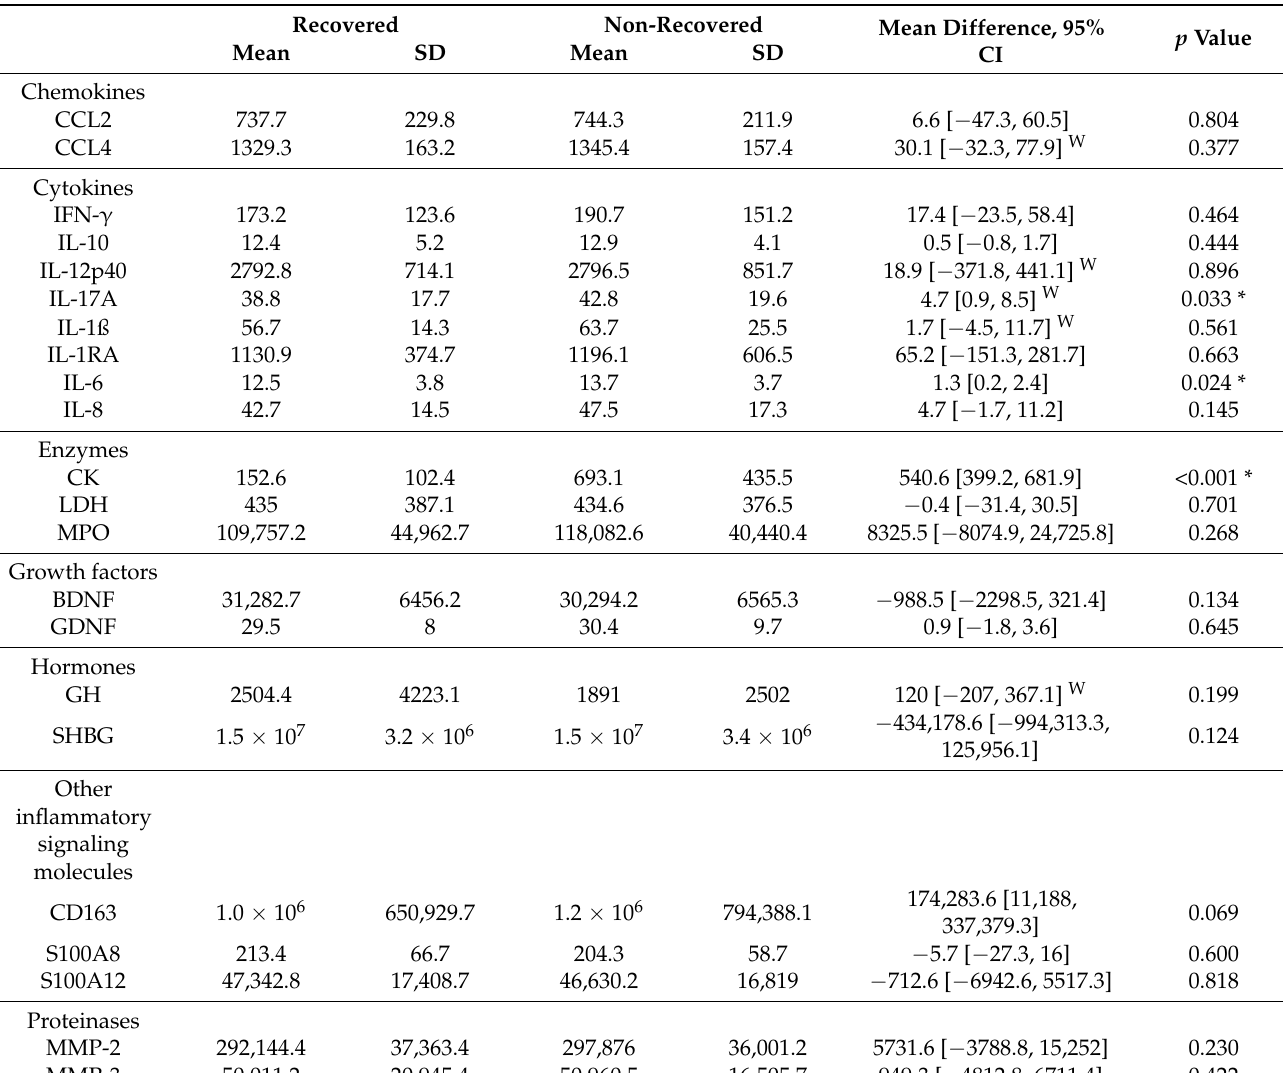
Table 3. Concentration of blood-based biomarkers at REC and NOR time points across disciplines (in pg/mL and U/L for